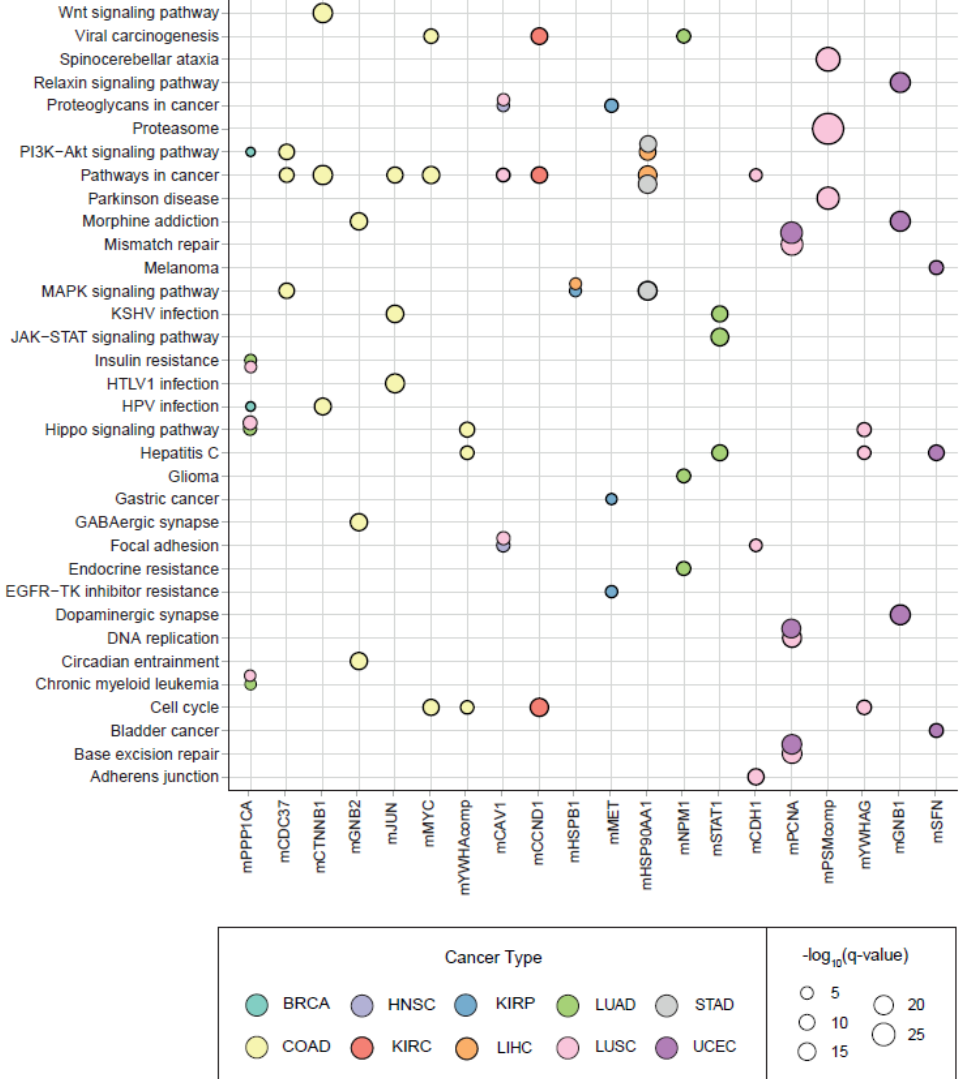
Figure 7. The pathway enrichment analyses results. The bubble plot indicates the diagnostic and prognostic 30 modules differentially interacting hallmark of cancer protein’s (DIHCP’s) pathway enrichment results according to q-value ( − log 10 ) significance.